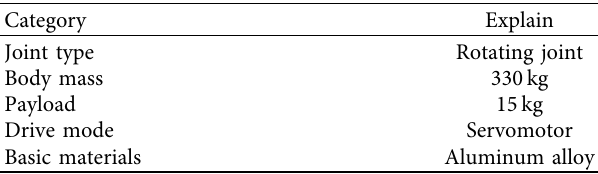
Figure 3: Te experimental platform device for the fve-axis redundant industrial robotic arm. Table 1: Basic parameters of the robotic arm.